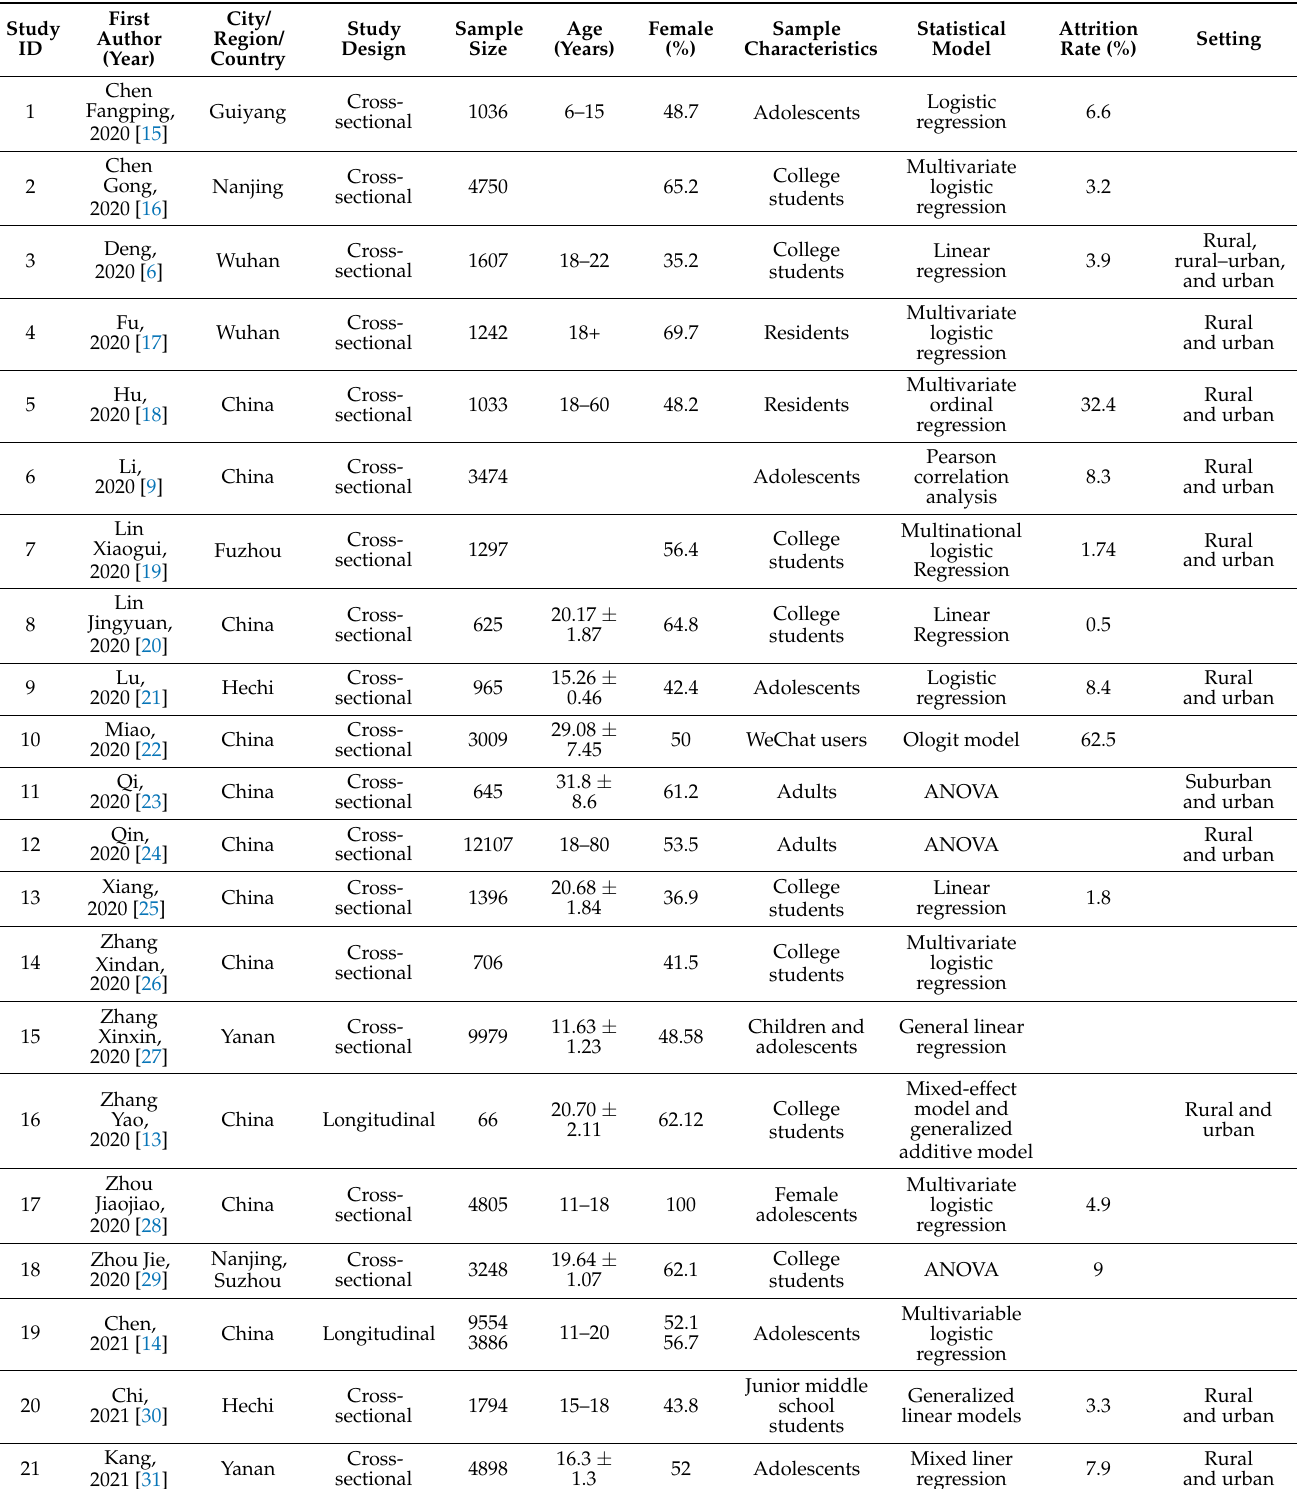
Table 1. Basic characteristics of the studies included in the